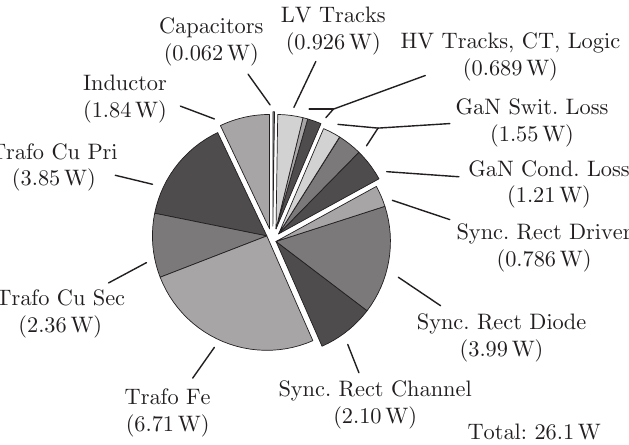
Figure 21. Experimental loss budget at 50% load of the ”Improved 1.5kW Module” of Figure 20 (”Module 1” in Figure 19), with v dc = 400V and V o = 12V, confirming the expected performance improvements calculated in Figure